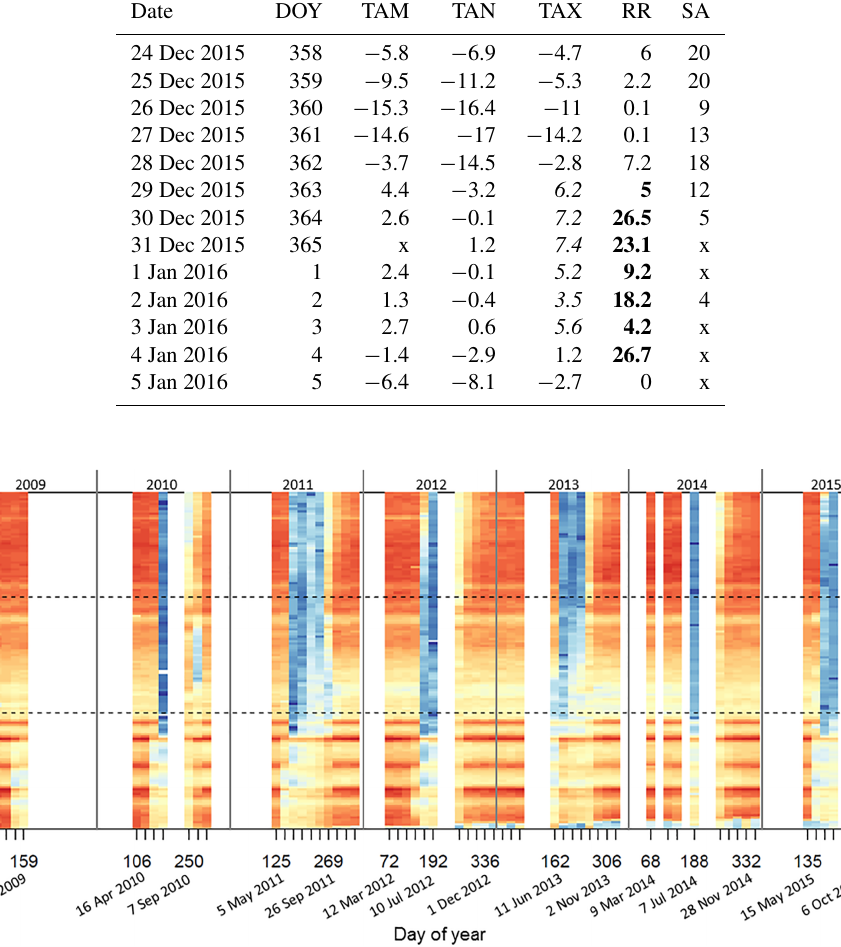
Figure A3. RADARSAT-2 time series of SAR backscatter values (dB) along a centerline profile on Holtedahlfonna from 2009 to 2015. Despite the time gaps in the RADARSAT-2 time series, the refreezing signal in the upper part of the firn area/zone is similar to the Sentinel-1 time series (Fig. 7a). This is shown by a gradual increase in backscatter in the firn zone right after the melt season, when the winter cold wave penetrates the firn and stabilizes